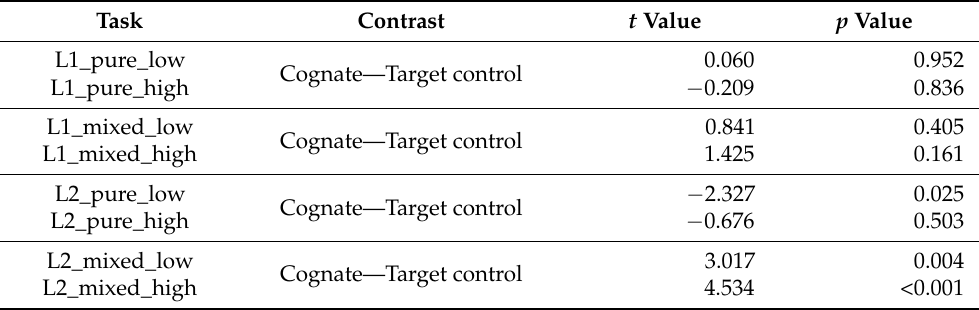
Table 8. Emmeans comparison of cognate versus target language control word processing by the low- and high-proficiency groups within the four